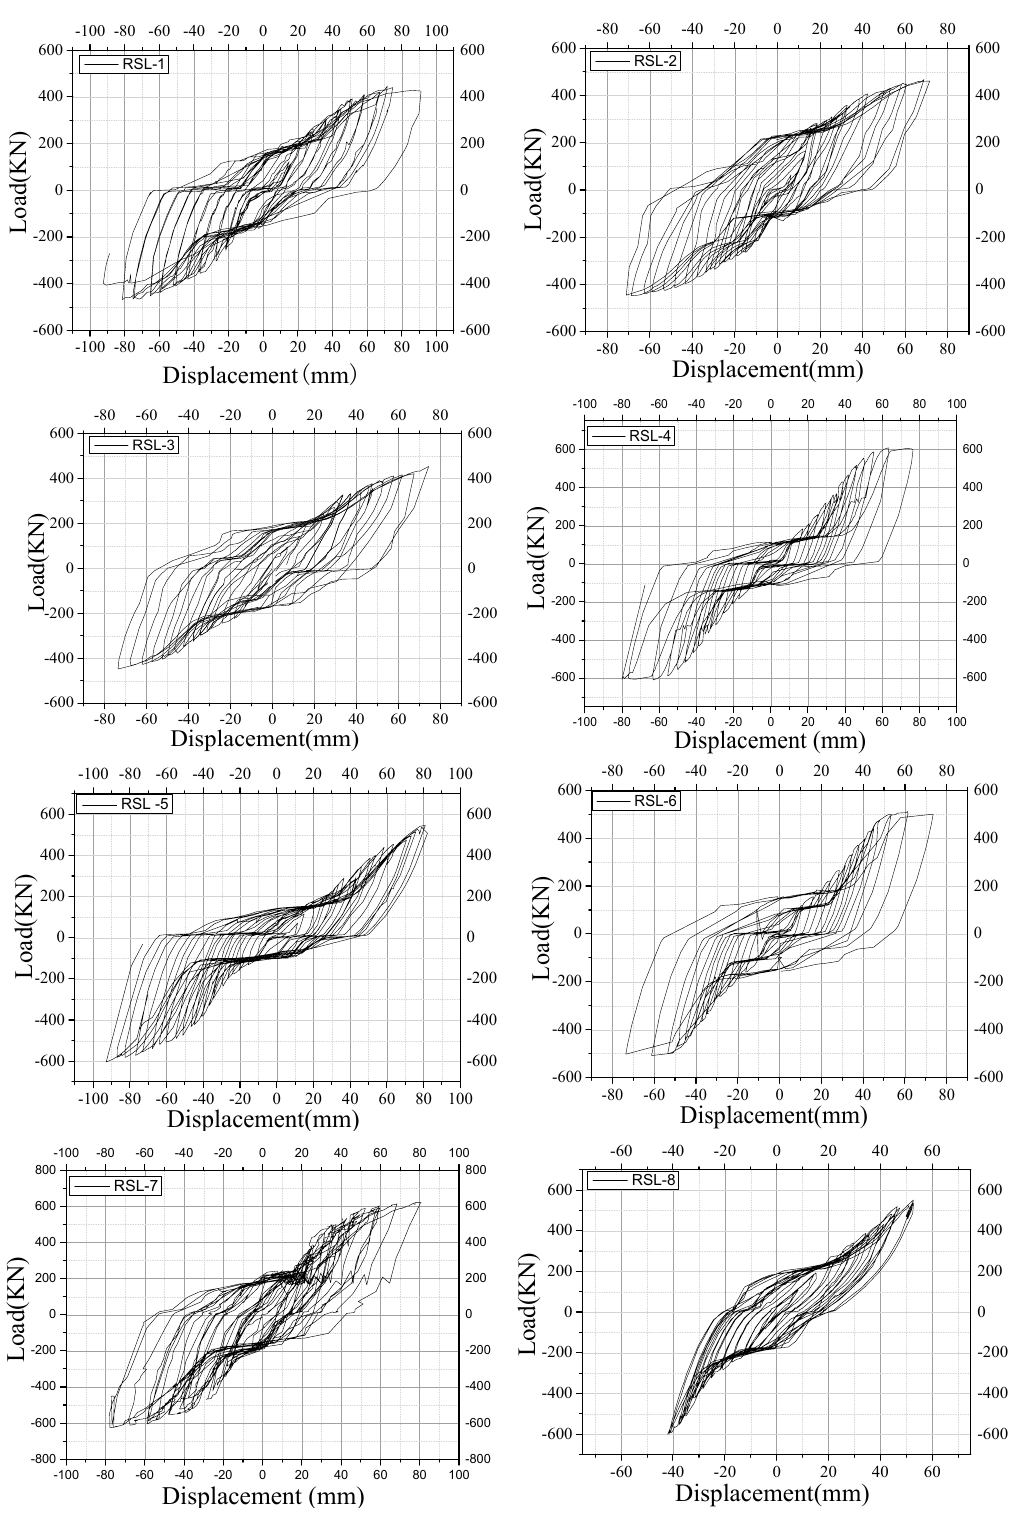
Figure 11. Hysteretic response of specimens.